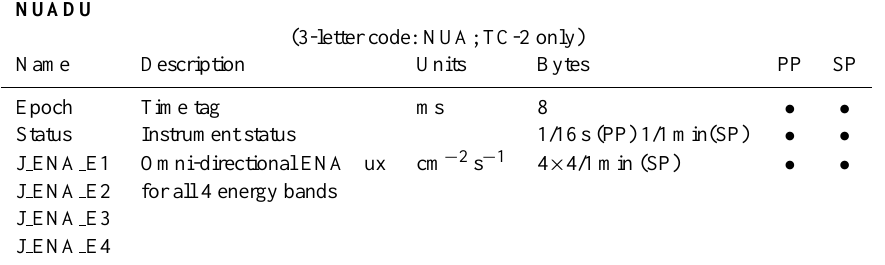
Table 3. NUADU database parameters. NUADU